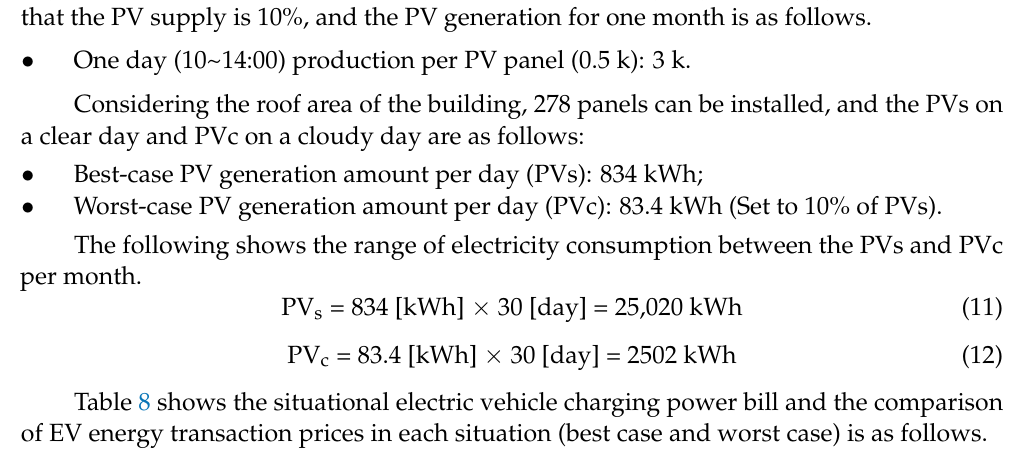
Table 8. Situational Electric Vehicle Charging Power Bill (Won/Kw)